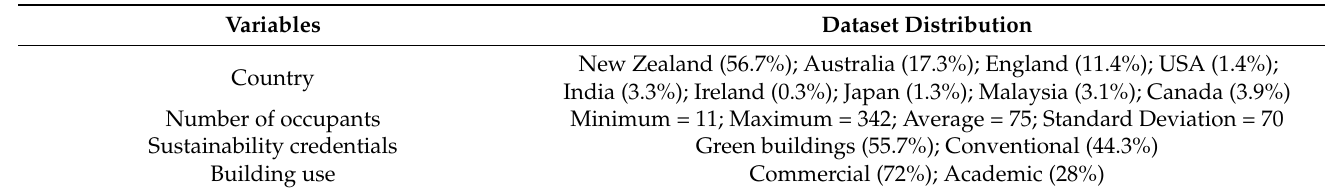
Table 2. Studied buildings in the dataset and building specifications.